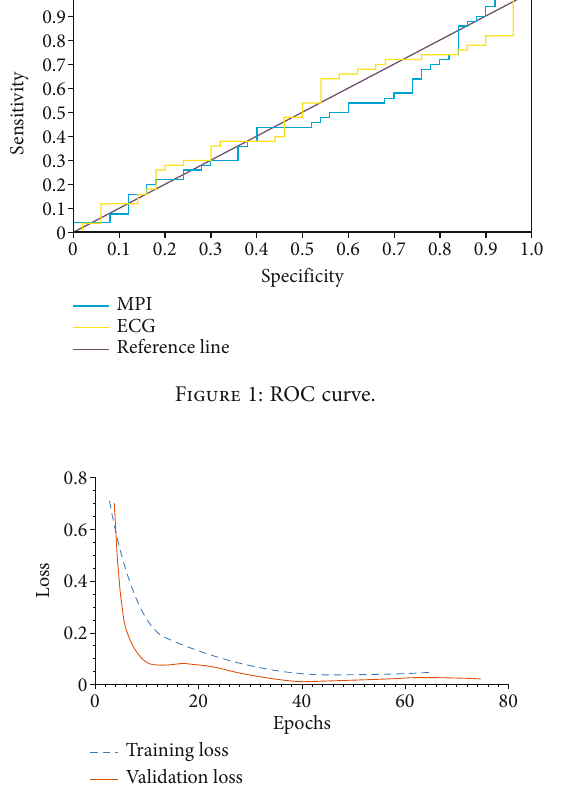
Table 3: Quantitative analysis of coronary